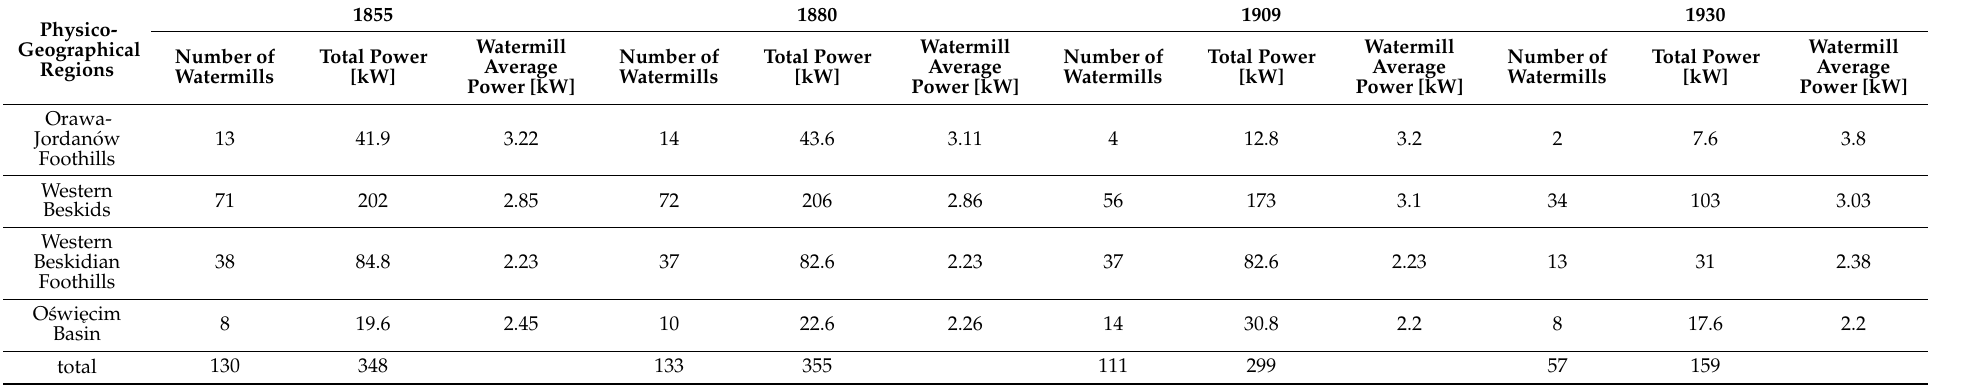
Table 4. Average power of watermills in the years 1855–1930, broken down into the main physico-geographical